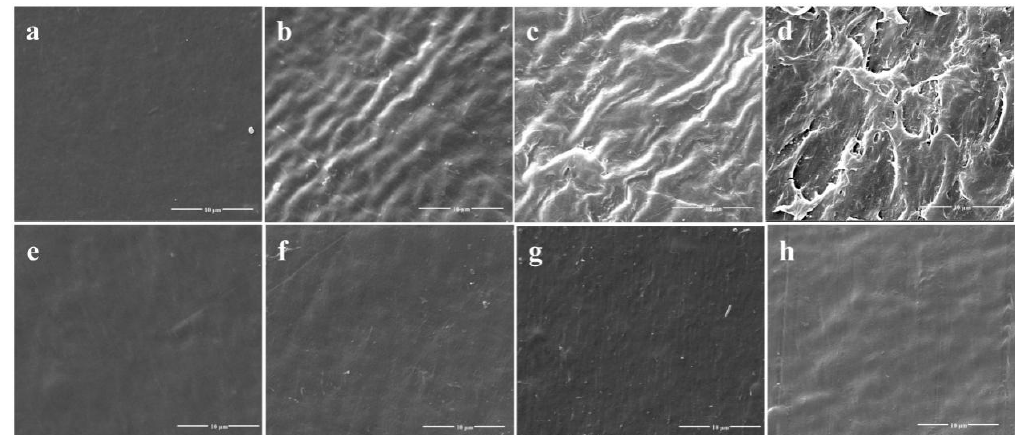
Figure 2. Scanning electron microscopy (SEM) observations of the physical surface topography of the untreated PE sheets versus PE sheets treated with strain LBX-2 after 0, 15, 30, 45 days, respectively. ( a – d ) Physical changes on the PE film sheets incubated with strain LBX-2 after 0, 15, 30, 45 days, respectively. ( e – h ) Physical changes on the PE film sheets without strain LBX-2 after 0, 15, 30, 45 days, respectively. Scale bar = 10 µ m.